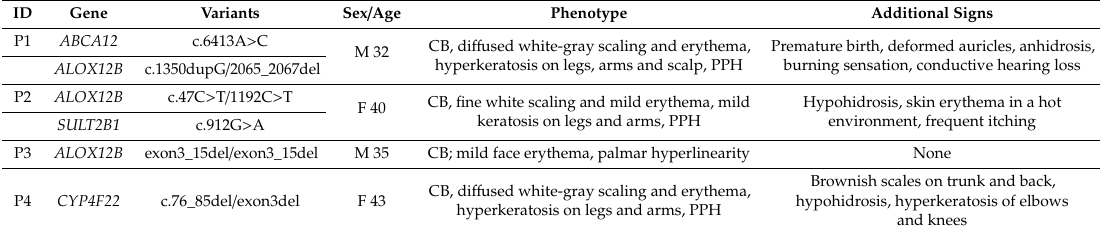
Table 3. Clinical features and associated genotypes of CIE patients under